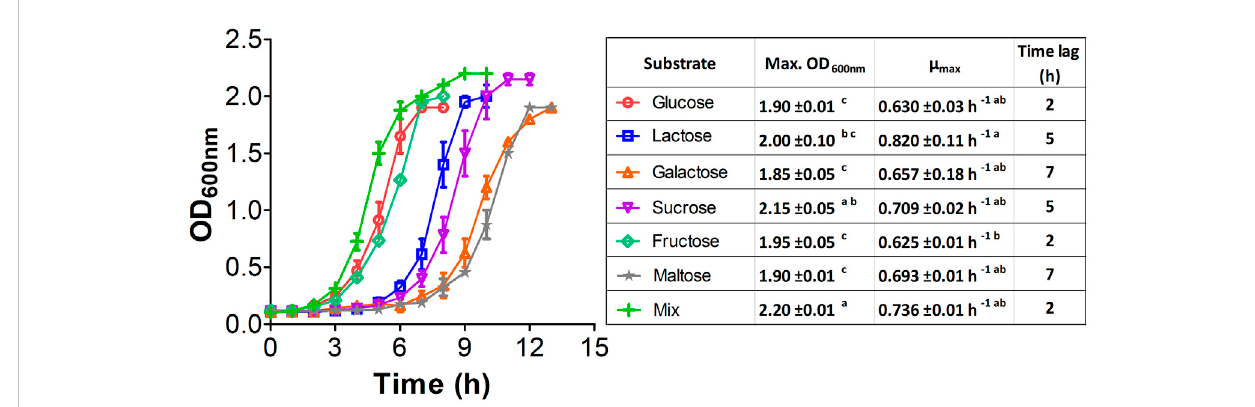
FIGURE 2 Growth kinetic of E. coli W using a variety of mono and disaccharides as sole carbon and energy source. 2 g/L of each single carbon source were usedwhileforthemixture,atotalof0.33 g/Lofeachcompoundwereused.Verticalbars,±representstandarddeviationandlinesareaguidefortheeye. Similar lowercase letters per column indicate no statistical difference between treatments ( p < 0.05).